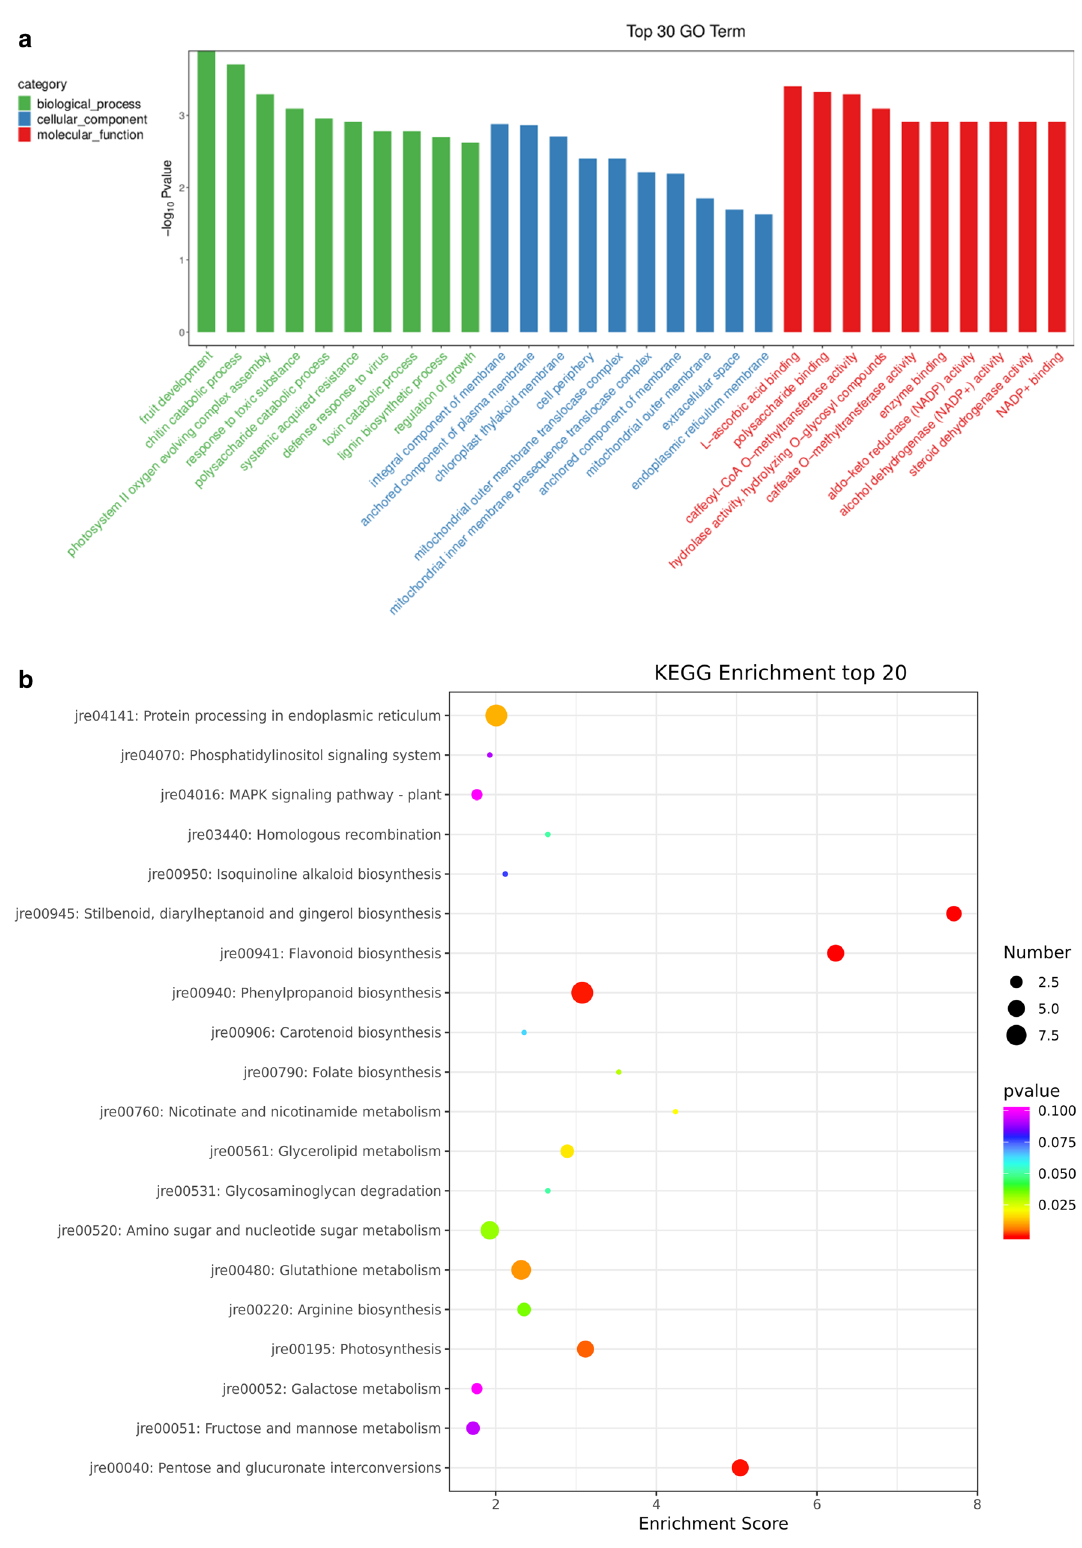
Figure 2. A GO classification of differentially expressed proteins under salt stress. Three main GO categories are summarized: BP, CC, and MF. BP, biological process; CC, cellular component; MF, molecular function. B The top 20 enriched gene ontology (GO) terms in the biological process under 0.6% NaCl stress for 48 h. The rich factor indicates the ratio of the number of DEPs in the pathway to the total number of genes in the pathway, and the higher the Rich factor, the higher the degree of